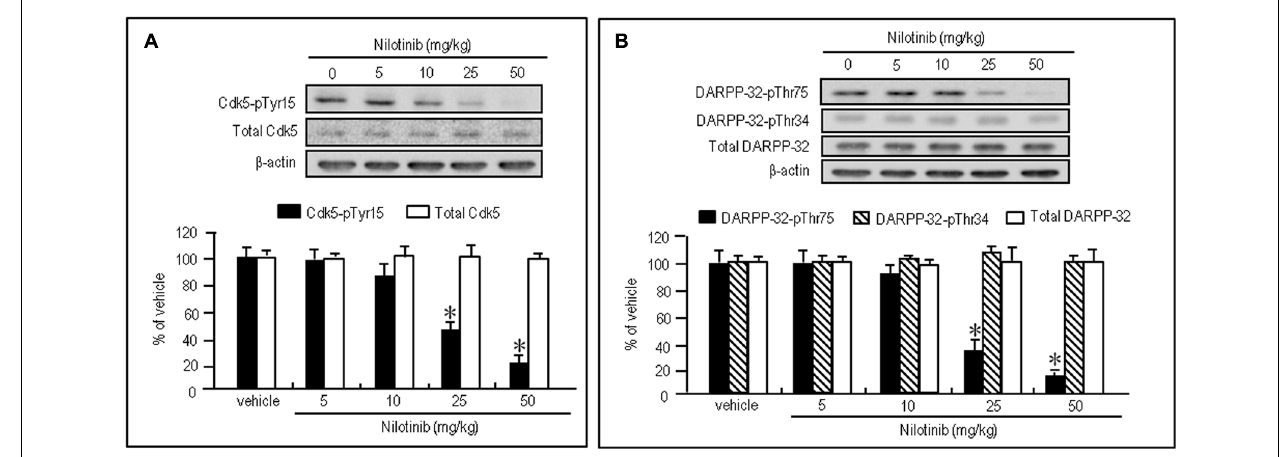
FIGURE 2 | Nilotinib affects striatal phosphorylation of Cdk5 and DARPP-32 in naïve mice. Western blot analysis was performed on striatal extracts from naïve mice that received intraperitoneal injections of nilotinib at doses of 5, 10, 25, or 50 mg/kg 30 min before they were sacrificed. (A) Optical density measurements of striatal Cdk5-pTyr15 and total Cdk5.Values are